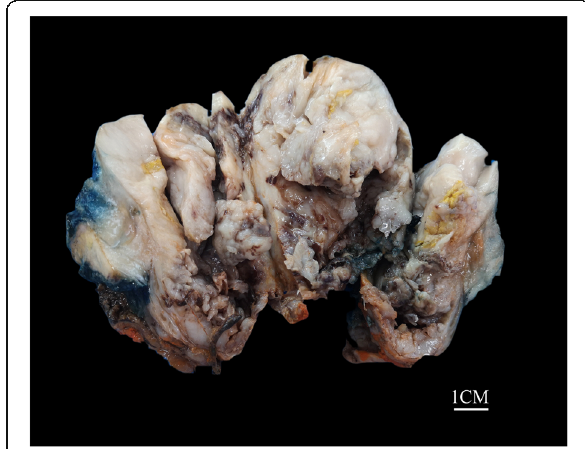
Fig. 2 Macroscopic features of ARID1A deficient undifferentiated spindle cell and rhabdoid sarcoma of the prostate. Gross examination showing a disrupted, 10 × 7 × 5 cm, solid and cystic mass involving almost the entire